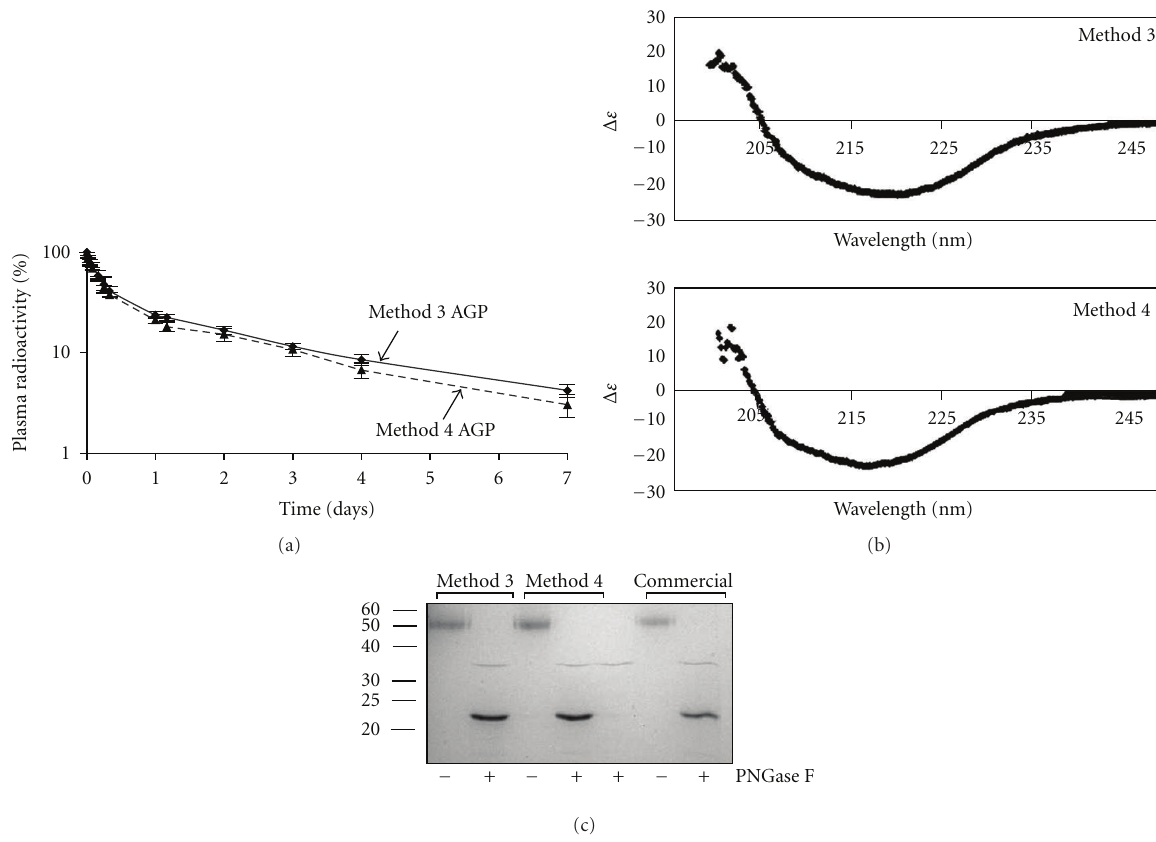
Figure 4: In vivo clearance, circular dichroism spectra, and deglycosylation of AGP purified by Methods 3 or 4. (a) shows residual, normalized acid-precipitable radioactivity in rabbit plasma following injection of radioiodinated AGP purified as indicated by arrowed text. (b) depicts circular dichroism spectra of AGP purified by Method 3 (upper) and Method 4 (lower); Δ ε represents the di ff erence between the absorption by AGP of left-handed and right-handed circularly polarized light at di ff erent wavelengths. (c) shows samples of AGP purified by either method, with (+) or without ( − ) reaction with PNGase F; reaction of commercial AGP (Sigma) is also shown. Molecular mass markers are shown at left in